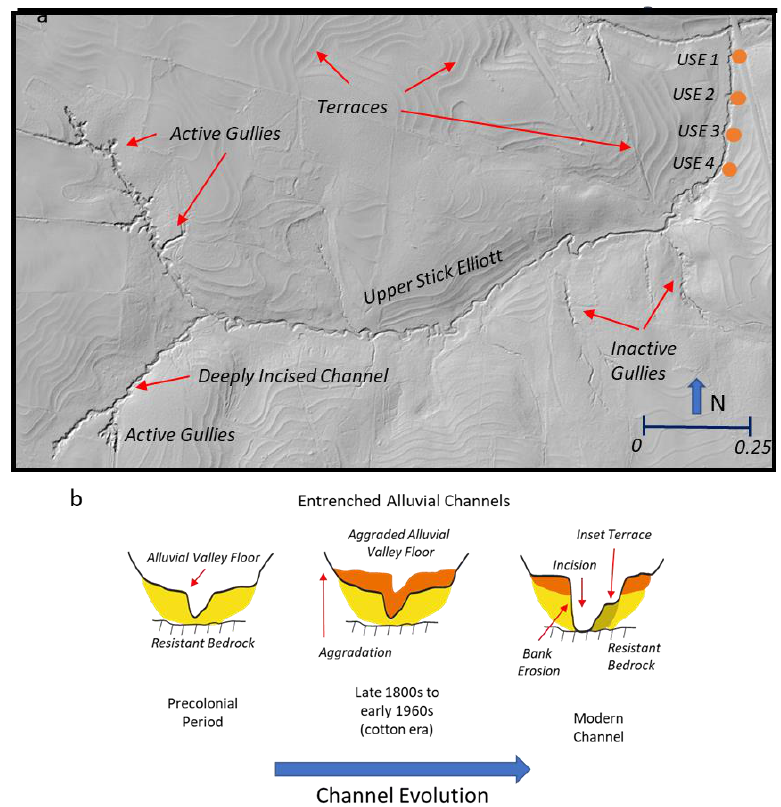
Figure 2. ( a ) LiDAR DEM showing detailed view of geomorphic features along Stick Elliott Creek. LiDAR DEM from the North Carolina Spatial Data Download Center (https://sdd.nc.gov/, accessed on 10 October 2019); ( b ) Schematic diagram of the geomorphic responses documented along the lower reaches of Big Harris Creek by Miller et al. [30] during and following European settlement.